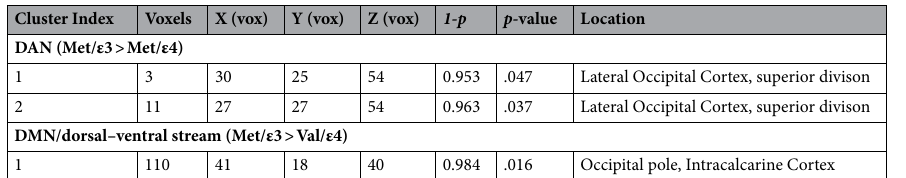
DMN/dorsal–ventral stream (Met/ε3 >